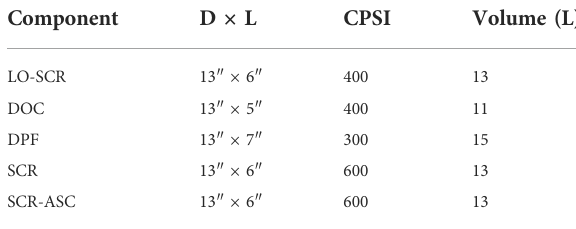
TABLE 2 Baseline 1 system catalyst speci fi cations. TABLE 3 Baseline 2 and EH testing catalyst speci fi